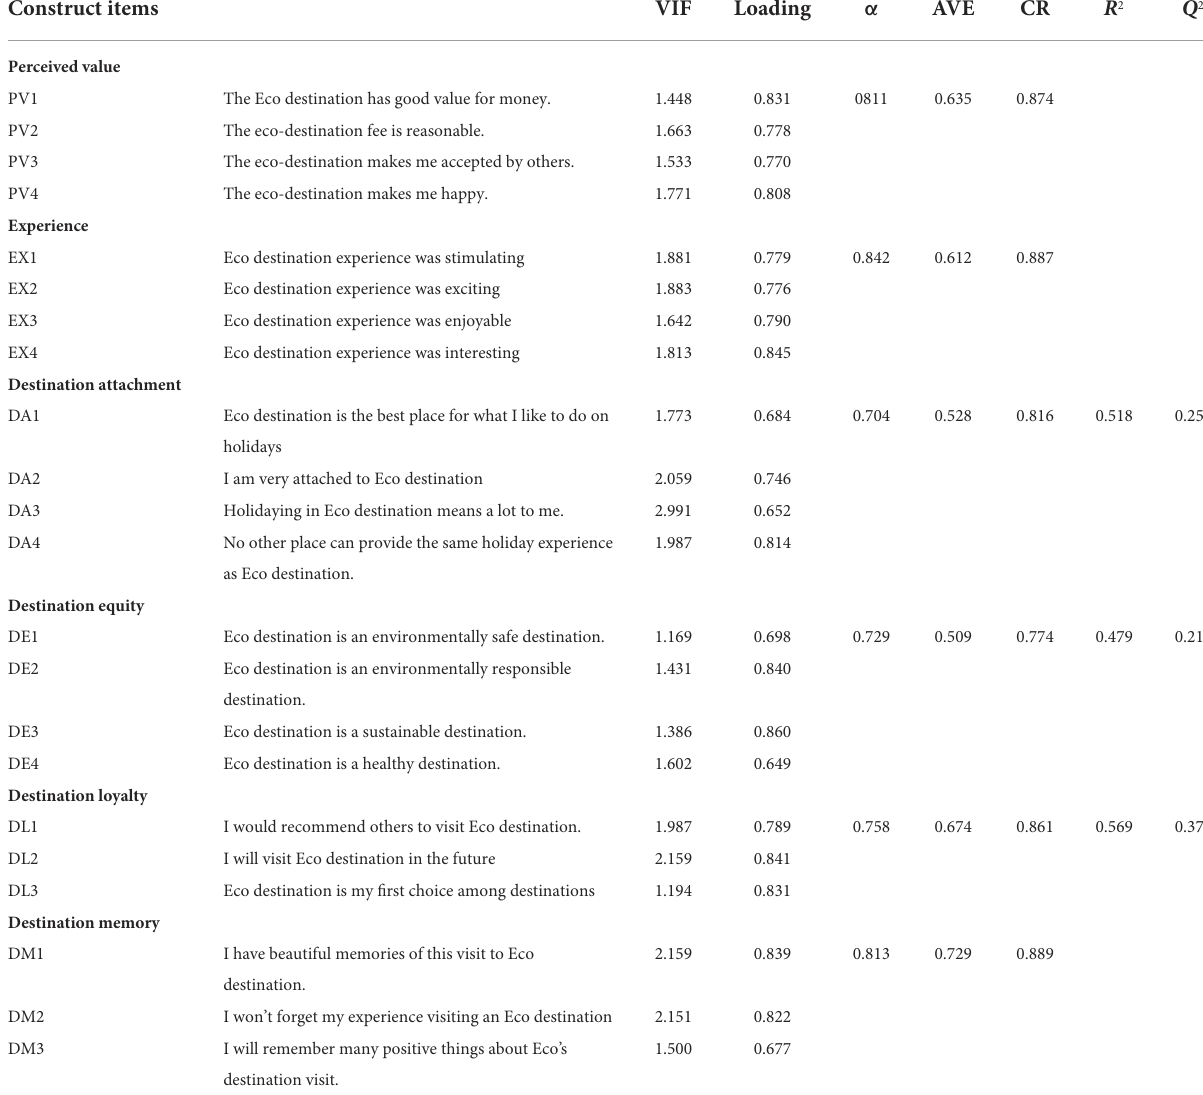
TABLE 2 Construct items, factor loading, AVE, Cronbach’s alpha, CR, R 2 , and Q 2 values are presented. Construct